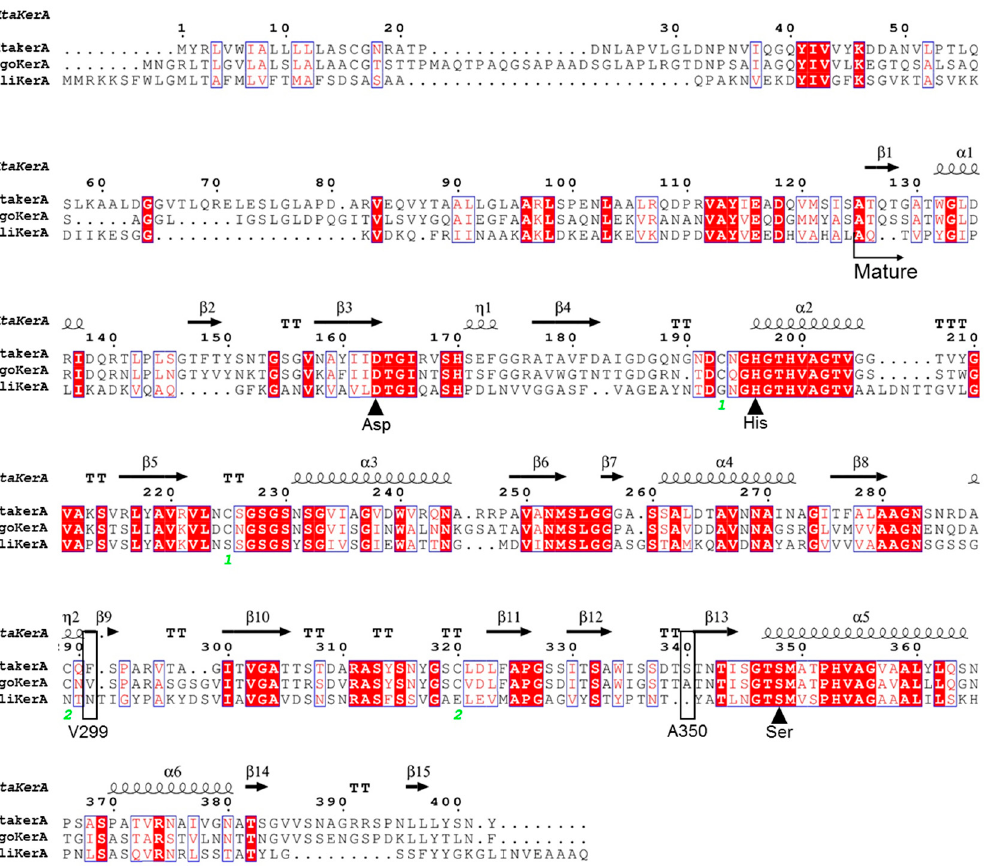
Figure 1. Phylogenetic analysis of amino acid sequence of keratinases. The name and GenBank ac- cession No. for each protease are in front of the Latin name of each strain. The phylogenetic tree was constructed by MEGA 6.0 with neighbor-joining (NJ) method. The percentages of replicate trees in which the associated taxa clustered together in the bootstrap test (1000 replicates) are shown next to the branches.